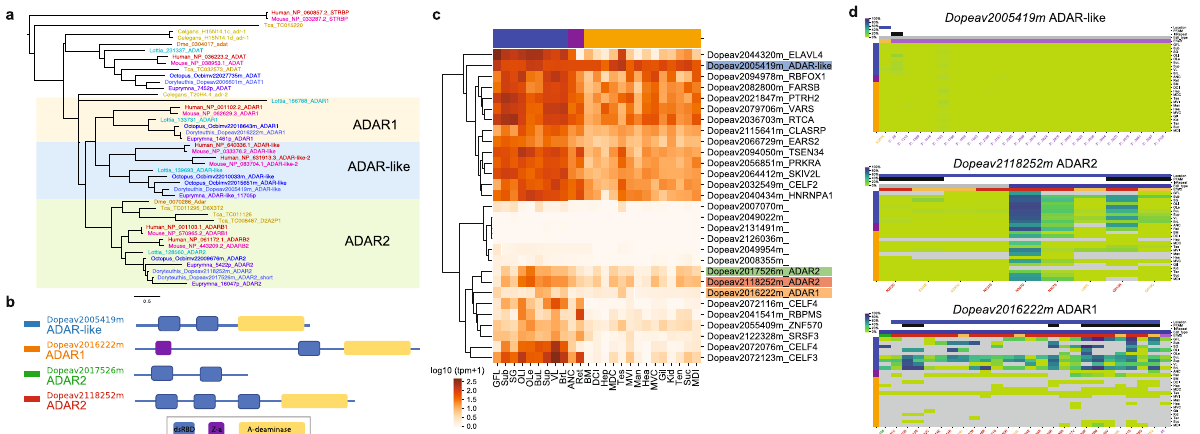
Fig. 7 Expression and editing of ADAR transcripts. a Phylogenetic tree of ADAR homologs. The colors highlight ADAR1, ADAR2, and ADAR-like families. b Cartoon representation indicating conserved domains present in squid ADAR proteins: double-stranded RNA binding Domains (dsmr), Z-binding domain binds (Z-a), Adenosine deaminase (A-deaminase). c Expression of genes with PFAM domains that interact with RNA that are enriched in neural samples. Tissue abbreviations as in Fig. 1 and color code in top row as in Fig. 6. d mRNA editing pro fi le of ADAR